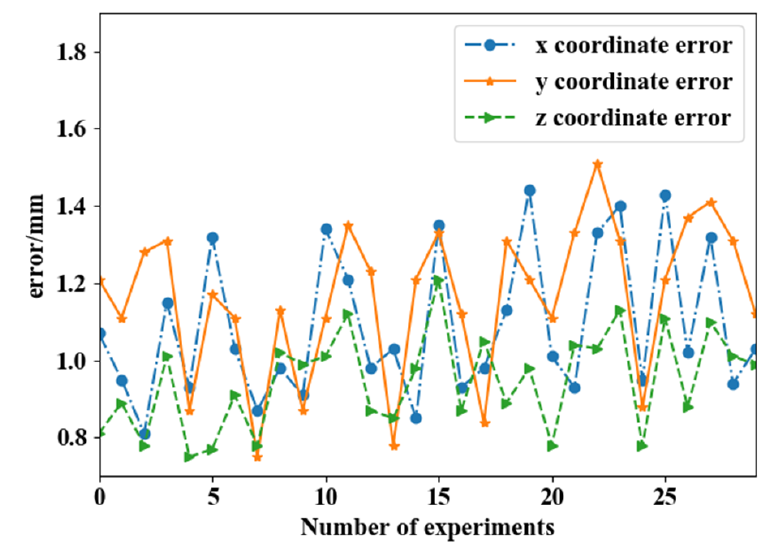
Figure 21. Assembly error analysis diagram.